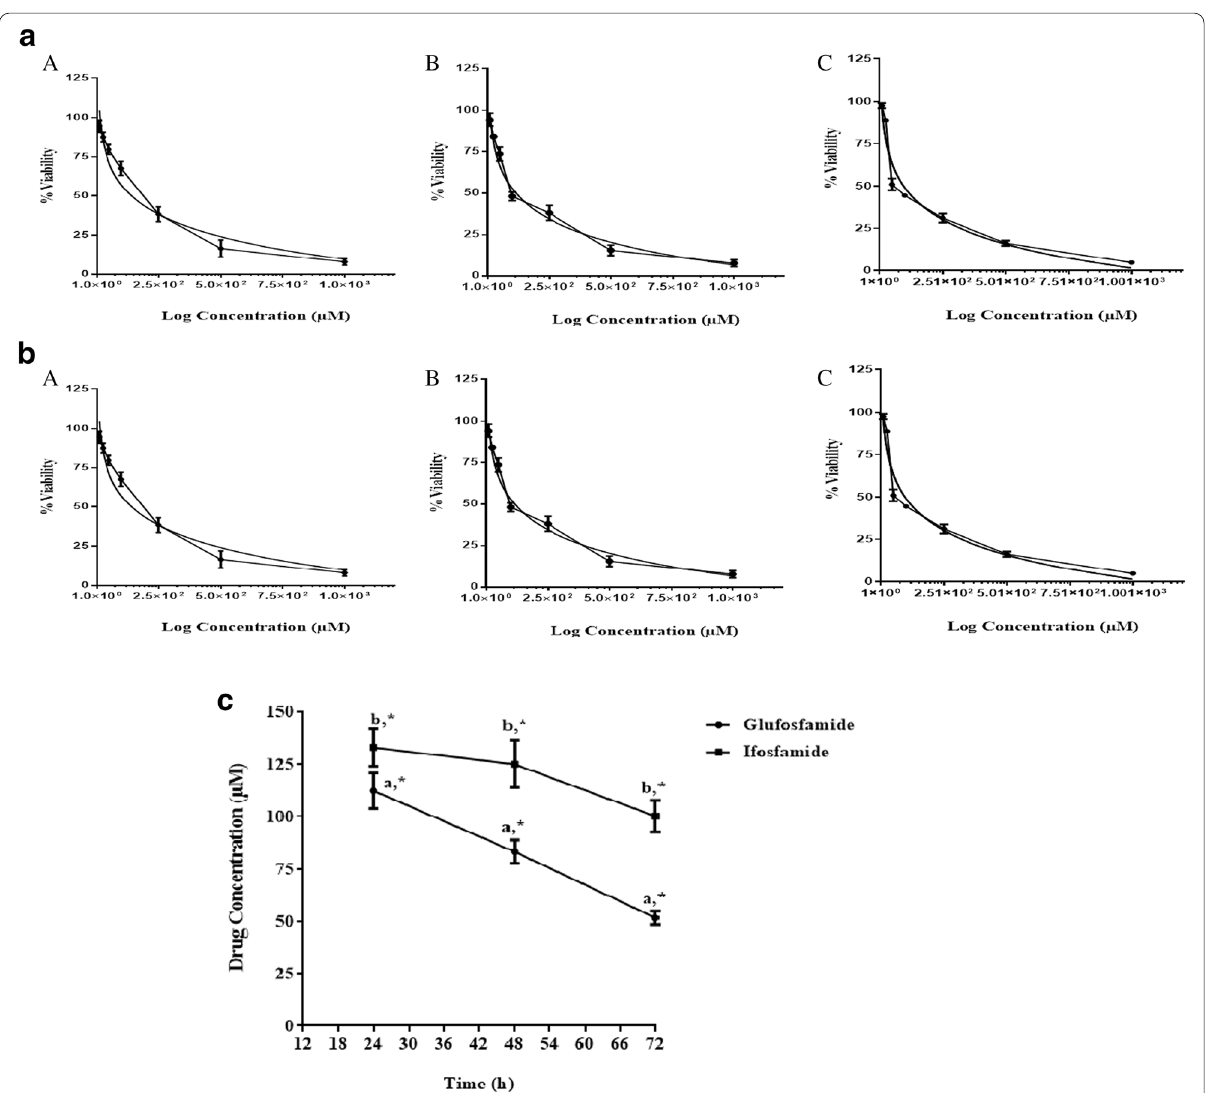
Fig. 1 Concentration response curves and Mean IC50 values of glufosfamide and ifosfamide on HepG2 cells. a Concentration response curves testing the effect of glufosfamide on HepG2 cells at different times A 24 h, B 48 h, and C 72 h. b Concentration response curves testing the effect of ifosfamide on HepG2 cells at different times A 24 h, B 48 h, and C 72 h. c Mean IC50 values for glufosfamide and ifosfamide at various time